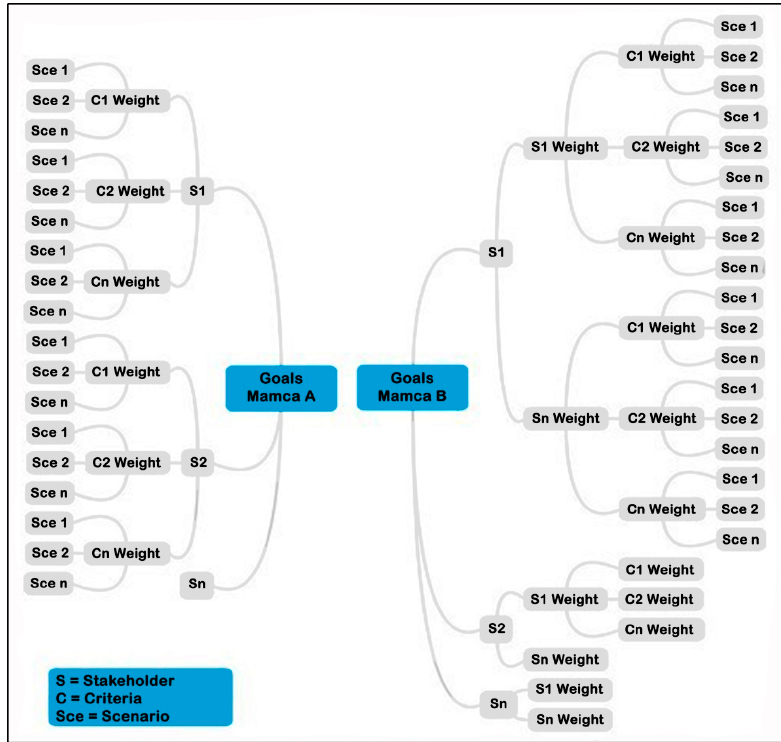
Figure 5. Differences in traditional MAMCA (A) and MAMCA with the stakeholder weight